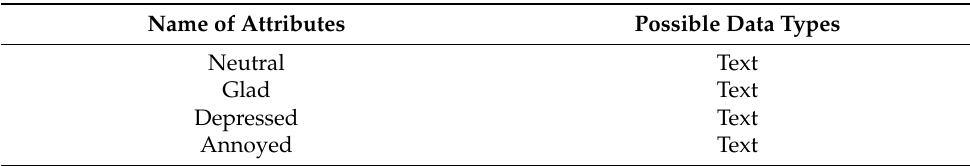
Table 2. Proposed attributes & possible data